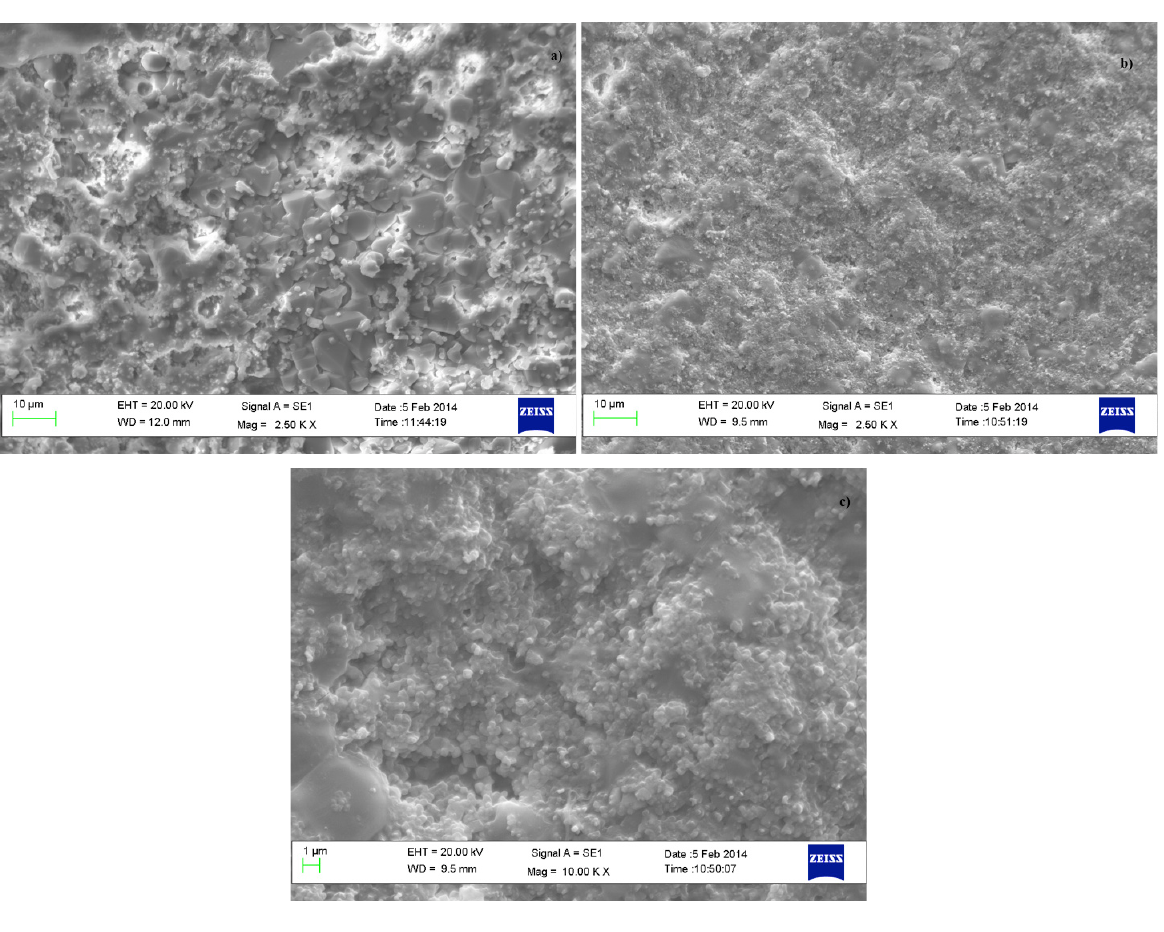
Figure 10. SEM micrographies (2500×) of the fired surface of samples with composition: OA20 ( a ) and OA40 ( b ). ( c ) shows an enlarged detail of Figure 10b